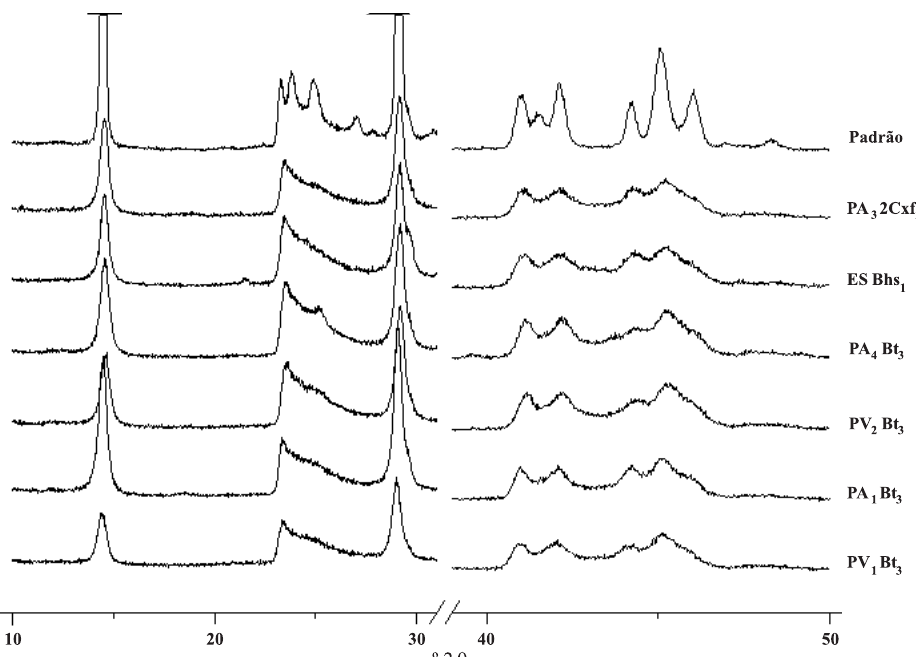
Figura 5. Espectro de difratometria de raios X das amostras estudadas de caulinita e amostra-padrão (Ct- Georgia) de alta cristalinidade.